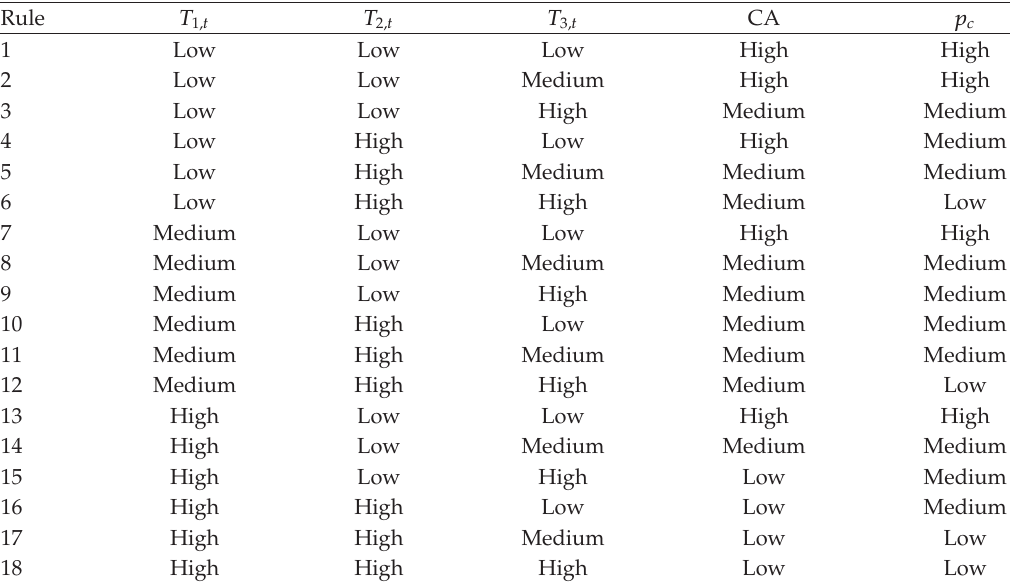
Table 6: Fuzzy rule base for CA and p c